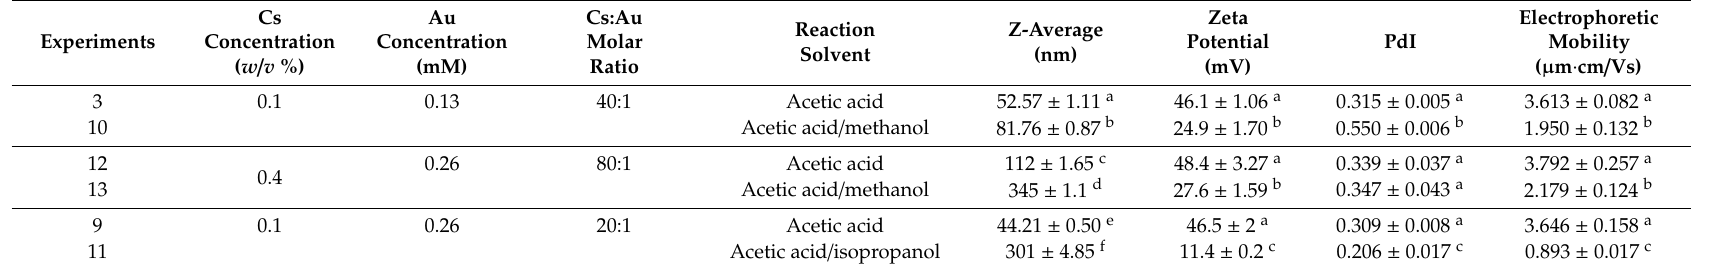
Table 4. Physical parameters of the Cs-AuNPs synthesized with MM w chitosan in the experiments 3-10, 12 − 13 and 9 −